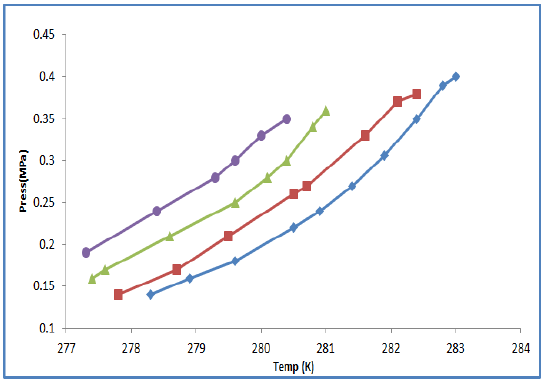
Fig. 10. R134a hydrate dissociation conditions in presence NaFsalt in present studywork: ■ without salt, ■ 0.09 mol ̸ kg , ▲ 0.17mol ̸ kg ● 0.26 mol ̸ kg